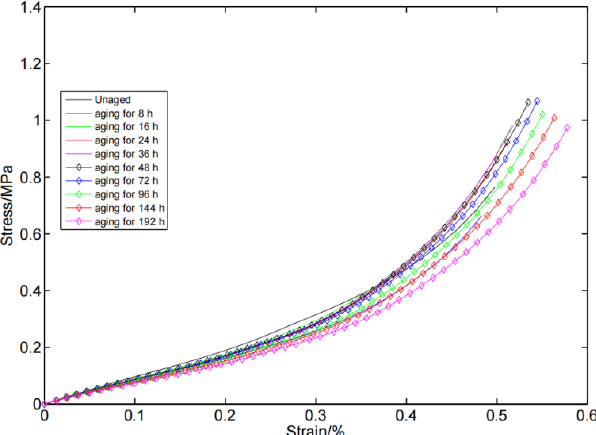
Figure 4. The stress–strain curves for silicone foam aged for different times.